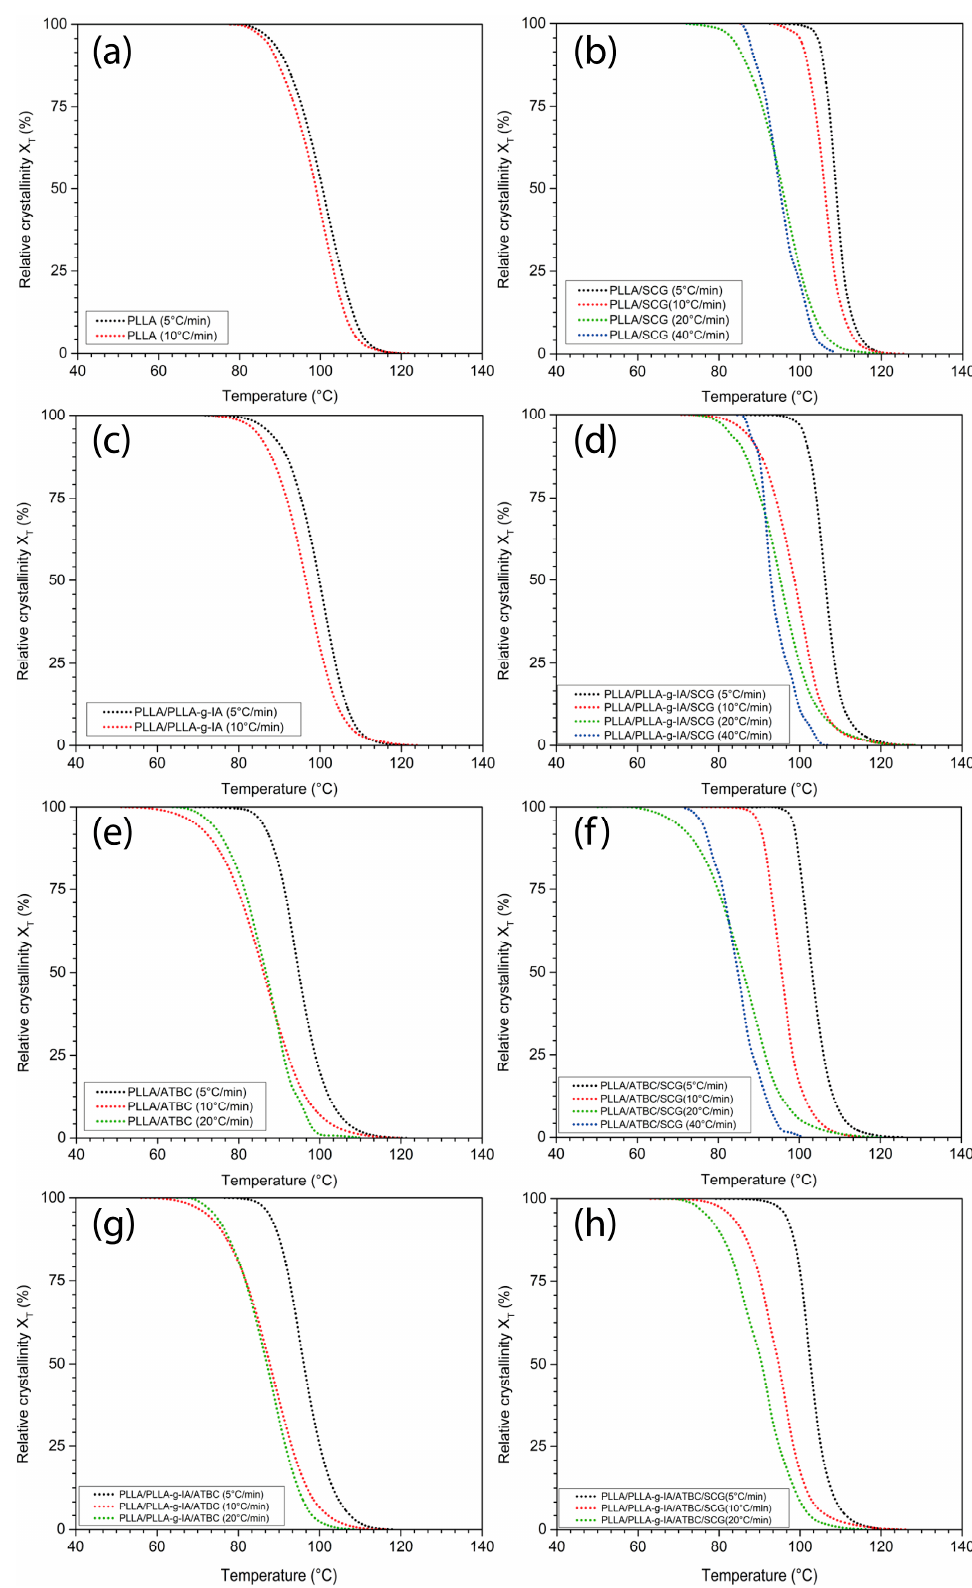
Figure 5. Variation in X T during the cooling rates 5, 10, 20, and 40 °C/min for ( a ) neat PLLA, ( b ) PLLA/SCG, ( c ) PLLA/PLLA-g-IA, ( d ) PLLA/PLLA-g-IA/SCG, ( e ) PLLA/ATBC, ( f ) PLLA/ATBC/SCG, ( g ) PLLA/PLLA-g-IA/ATBC, and ( h ) PLLA/PLLA-g-IA/ATBC/SCG.